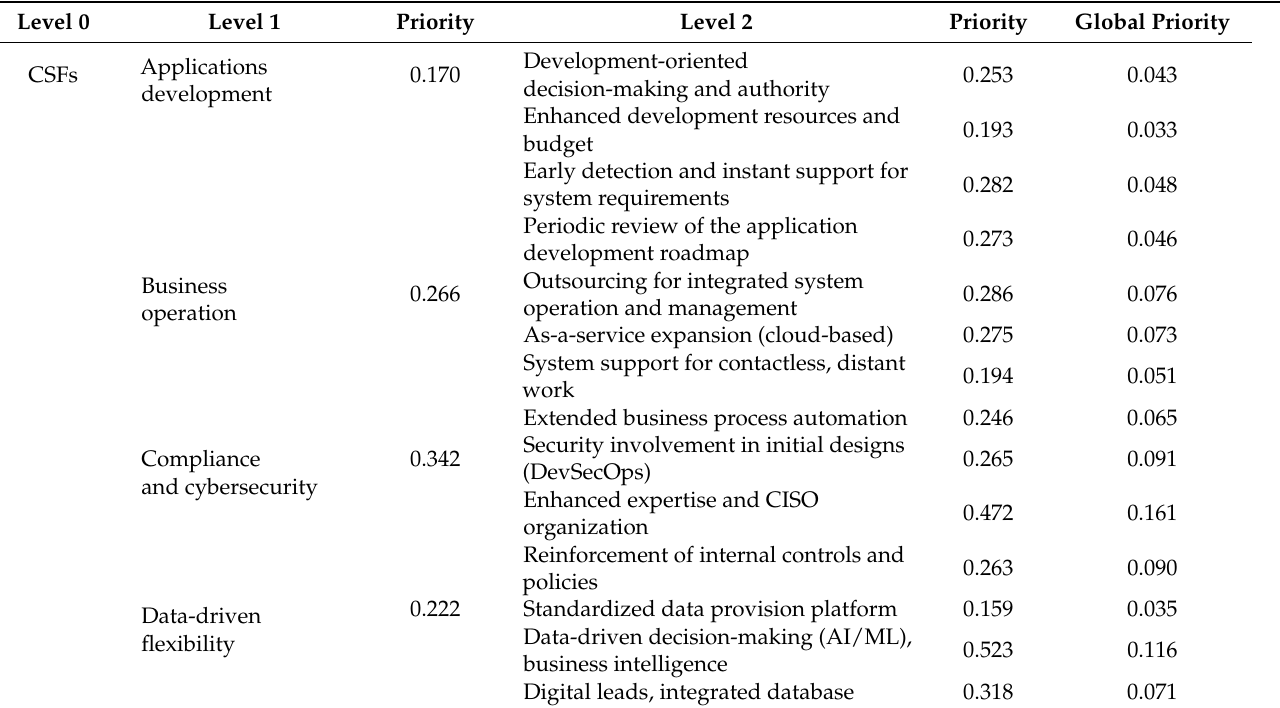
Table 16. CSF hierarchy for dimensions and